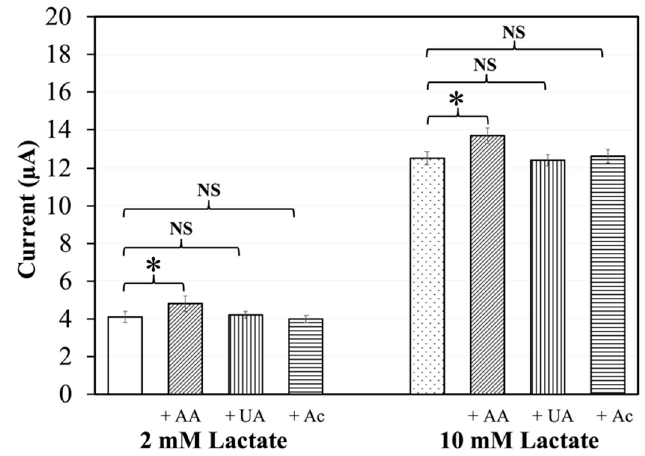
Figure 4. Response currents of lactate sensors to 2 mM or 10 mM lactate in the absence and presence of redox substances: 0.17 mM ascorbic acid (AA), 0.1 mM uric acid (UA) or 0.3 mM acetaminophen (Ac). * Student’s unpaired t- test value p < 0.05 (suggesting a significant difference between data); NS: p > 0.05 (suggesting no significant differences between data). Sensor composition: 1 U Av LOx A96L, 100 nmol mPES, 40 μ g sucrose, and 20 μ g Tween 20. Waiting time: 60 s. Applied potential: +0.2 V vs. Ag/AgCl. N = 3. Sampling point: 10 s.